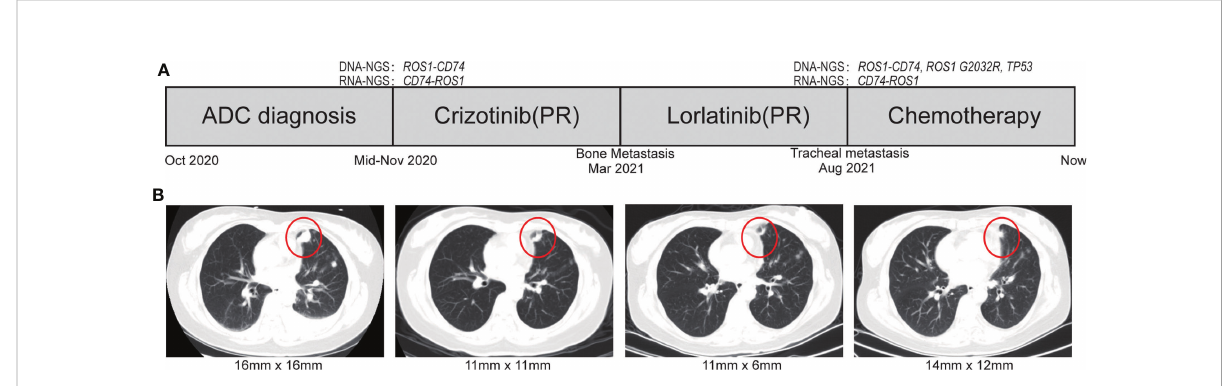
FIGURE 1 The treatment scheme and representative CT scan images during treatment. (A) Treatment scheme. (B) The representative CT scan of during treatment courses. ADC, adenocarcinoma; SD, stable disease; PR, partial